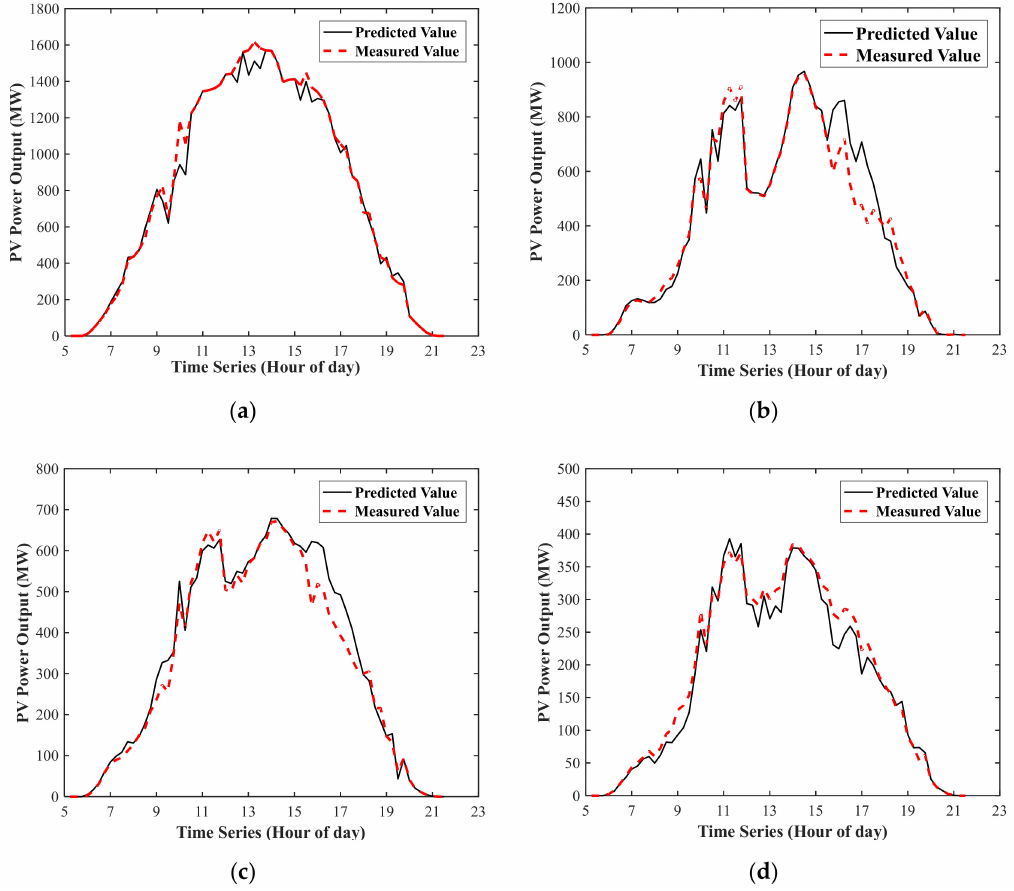
Figure 10. Sub-region PV output prediction results. ( a ) PV power prediction of sub-region 1; ( b ) PV power prediction of sub-region 2; ( c ) PV power prediction of sub-region 3; ( d ) PV power prediction of sub-region